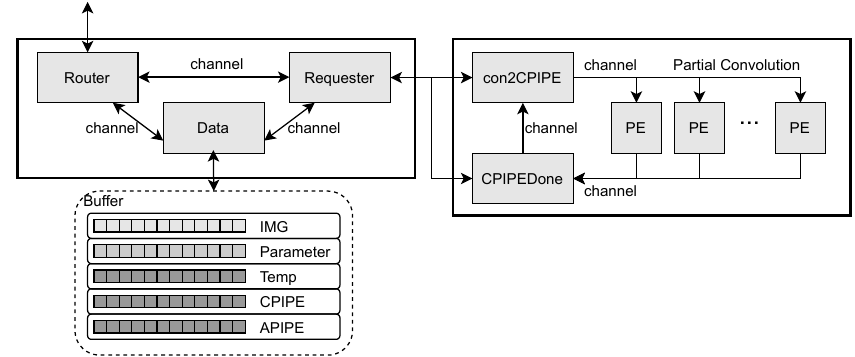
Figure 4. The internal modules decomposition of Data Loader